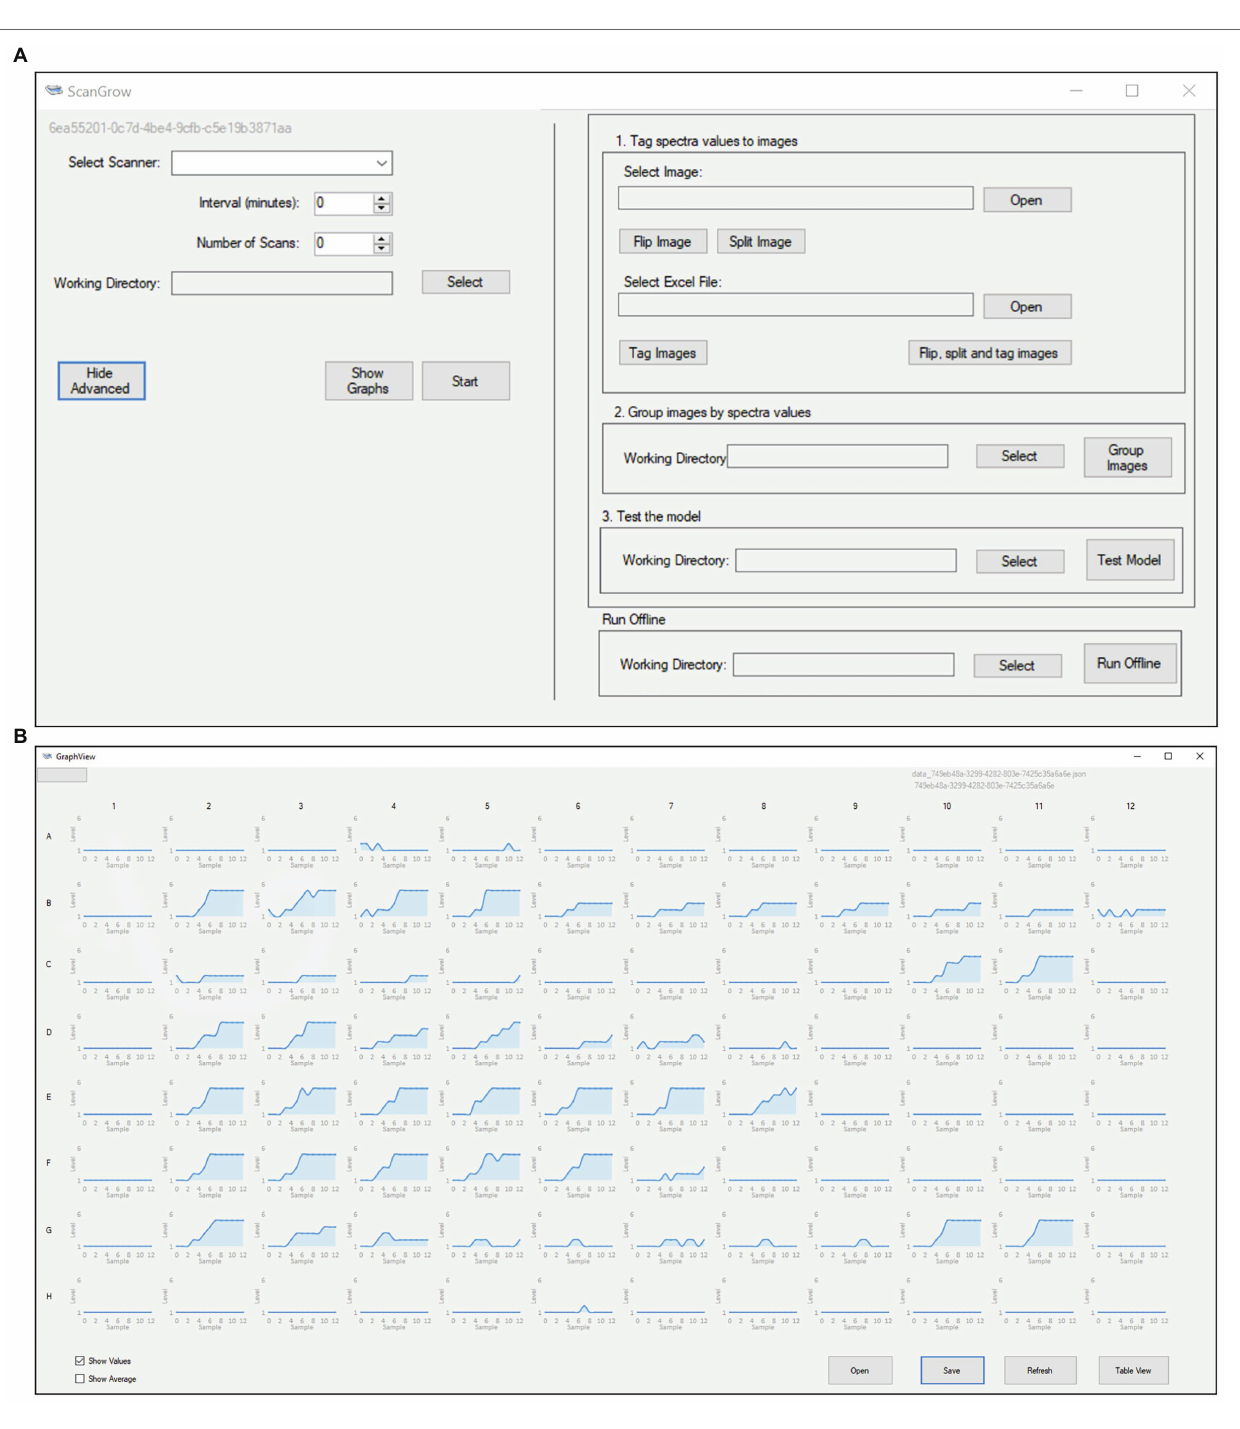
FIGURE 2 | Graphic User Interface of the ScanGrow application: (A) Main application menu, which grants access to all the functionalities from a single window; (B) Graph View, which allows for the visualization of 96 different growth